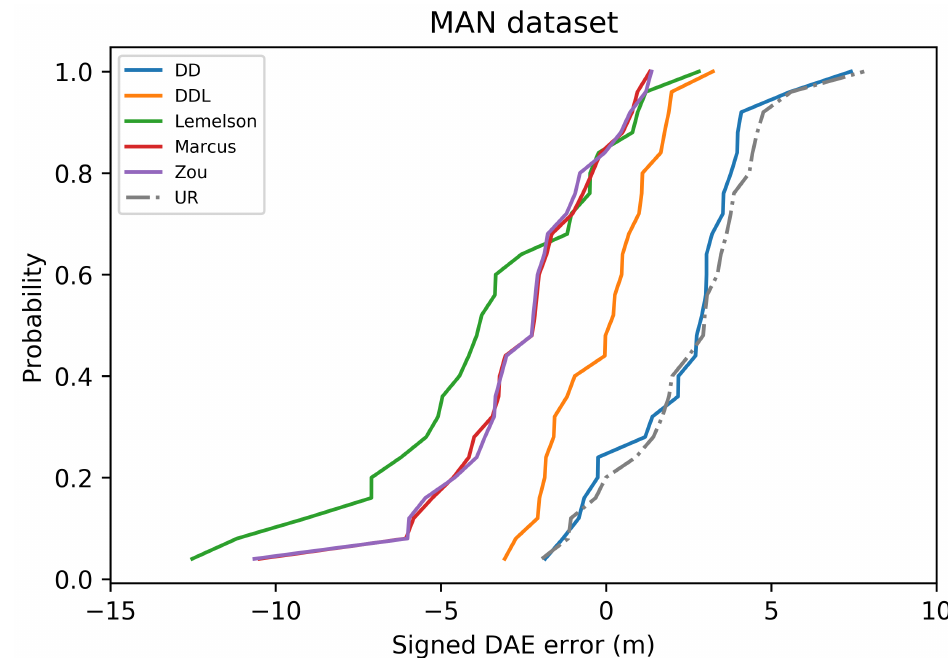
Figure 23. The Cumulative Distribution Function (CDF) of the signed DAE error (in meters) for all studied methods and one baseline, in the validation set of the MAN dataset. Negative values correspond to DAE overestimating the error (“ground-truth position inside the DAE circle”), while positive values correspond to DAE underestimating the error (“ground-truth position outside the DAE circle”).